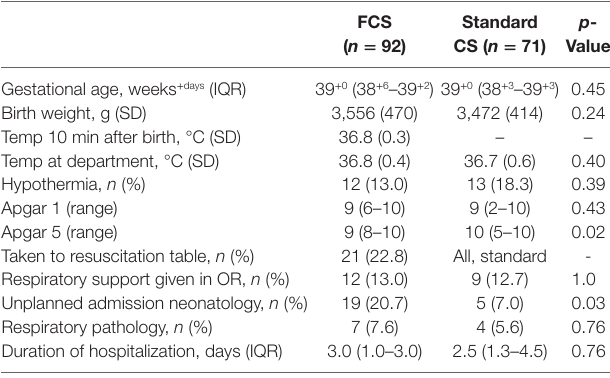
TaBle 1 | Outcome of infants with